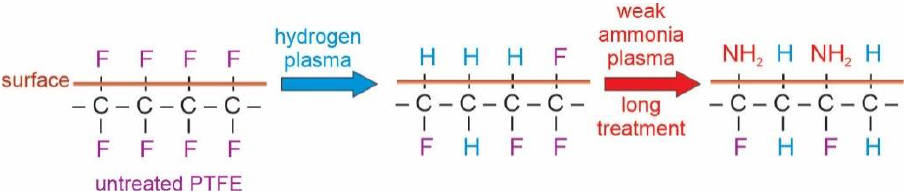
Figure 14. Simplified illustration of the effect of ammonia plasma sustained at the small power and long treatment times.